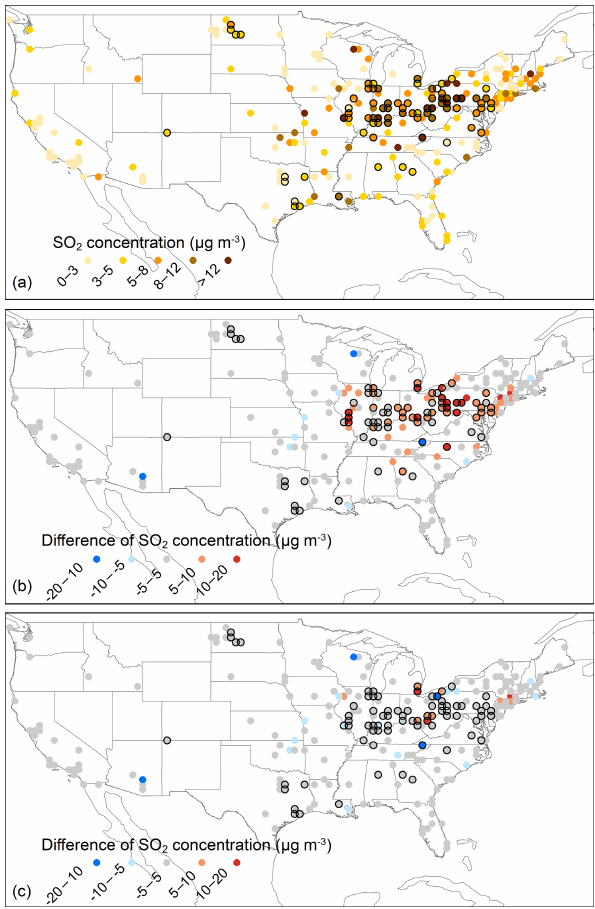
Figure 5. Annual averaged SO 2 surface concentrations from AQS measurements in 2010 (a) and their differences between the mod- eled SO 2 using the HTAP (b) and the OMI-HTAP inventory, 2010 (c) . AQS measurements are subtracted from the modeled SO 2 to derive the differences. The outline of circles corresponding to the grid cells with differences in emissions between the HTAP and the OMI-HTAP inventories is highlighted in